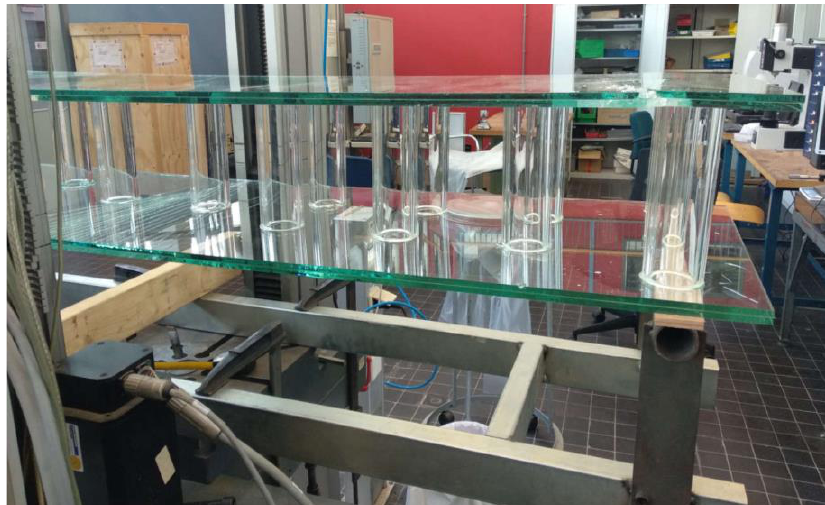
Fig. 7 Production of prototype panel.